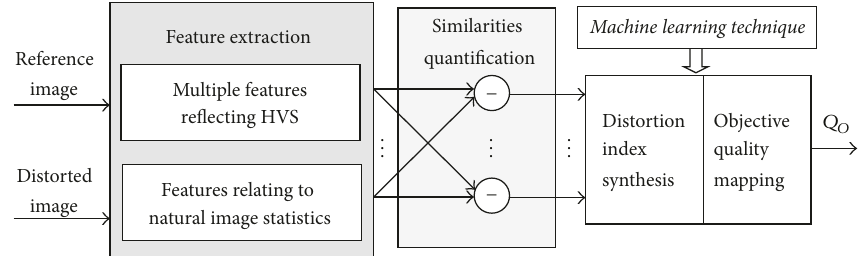
Figure 1: General framework of full reference IQA.